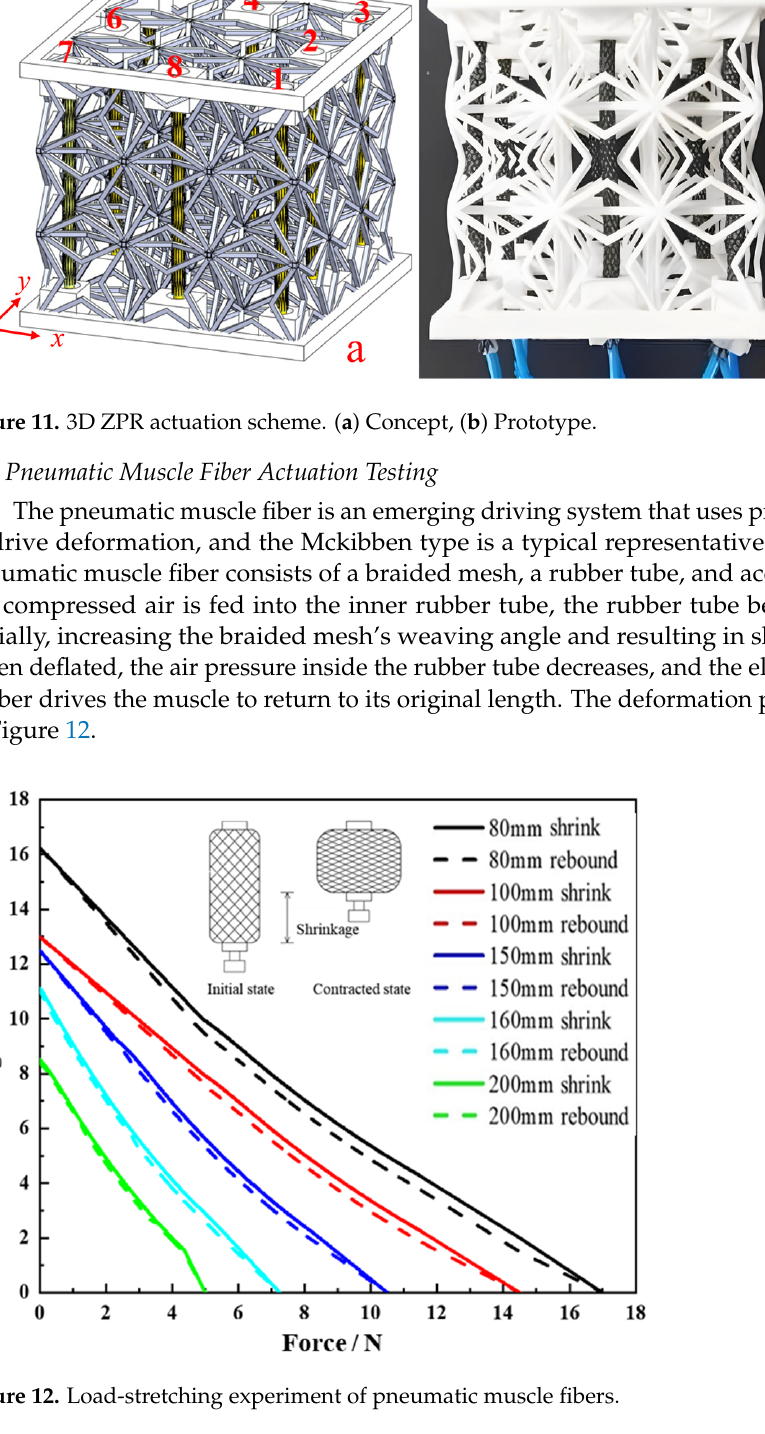
Figure 11. 3D ZPR actuation scheme. ( a ) Concept, ( b ) Prototype.